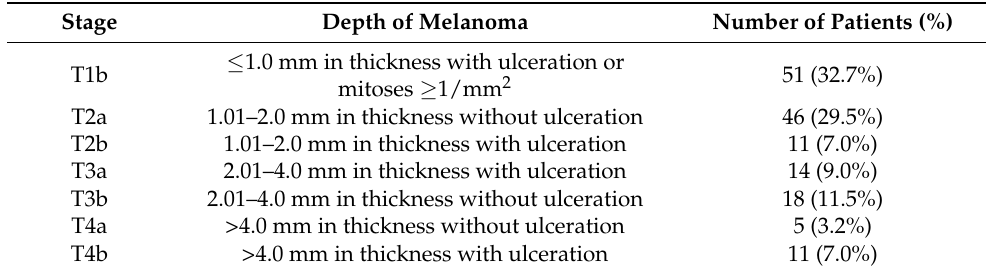
Table 2. T classification of reported Melanomas.